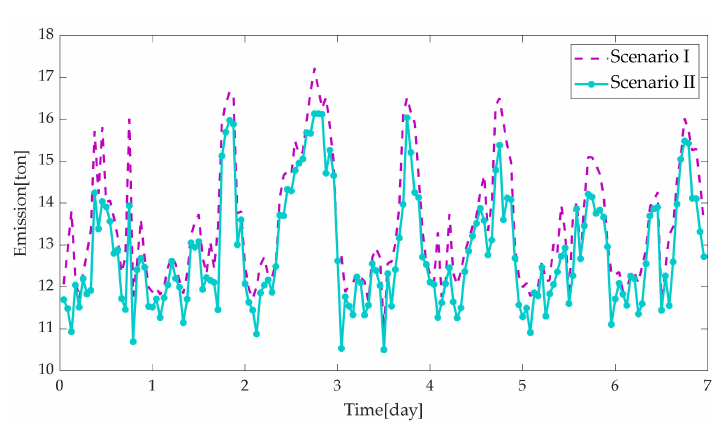
Figure 7. Comparison of SO 2